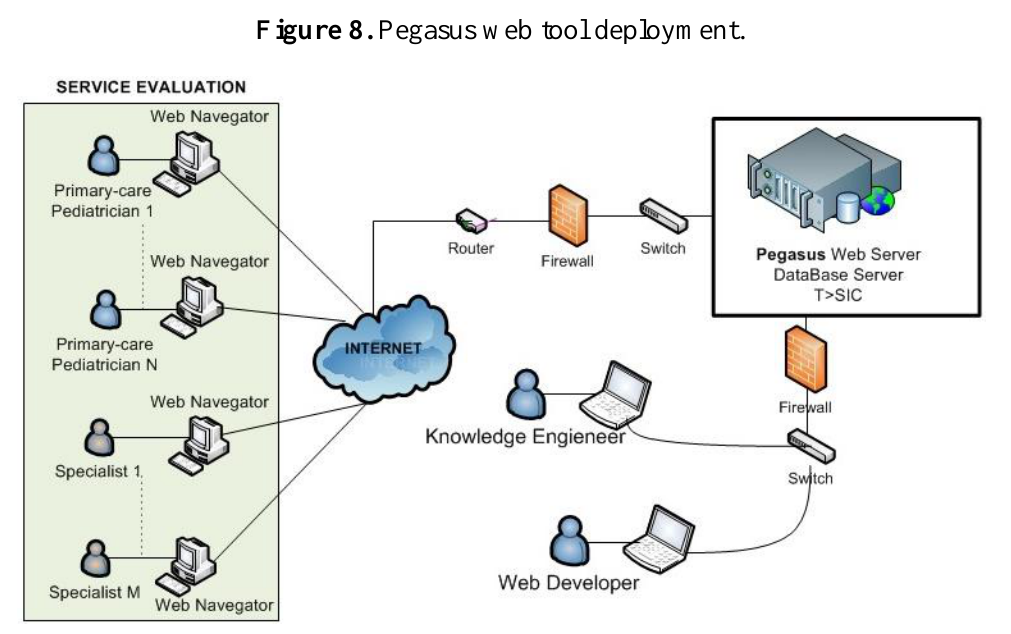
Figure 8. Pegasus web tool